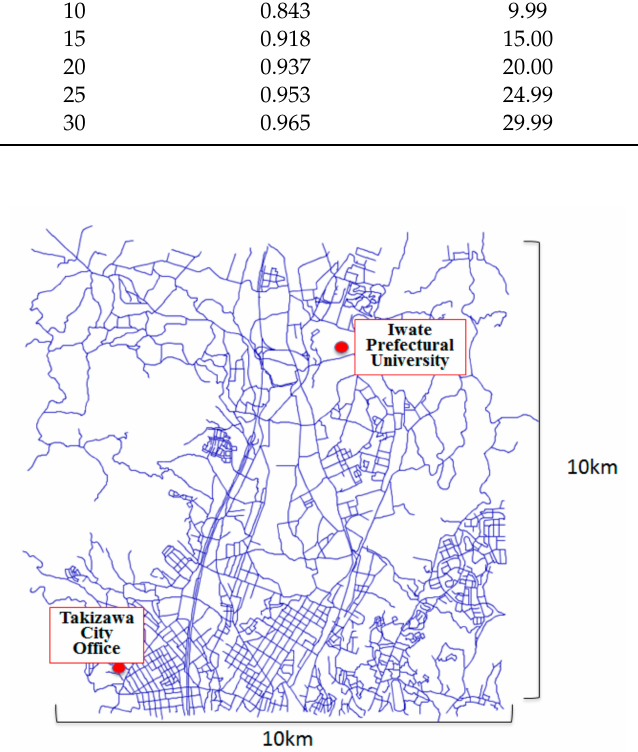
Figure 11. GIS map in the network simulator in the